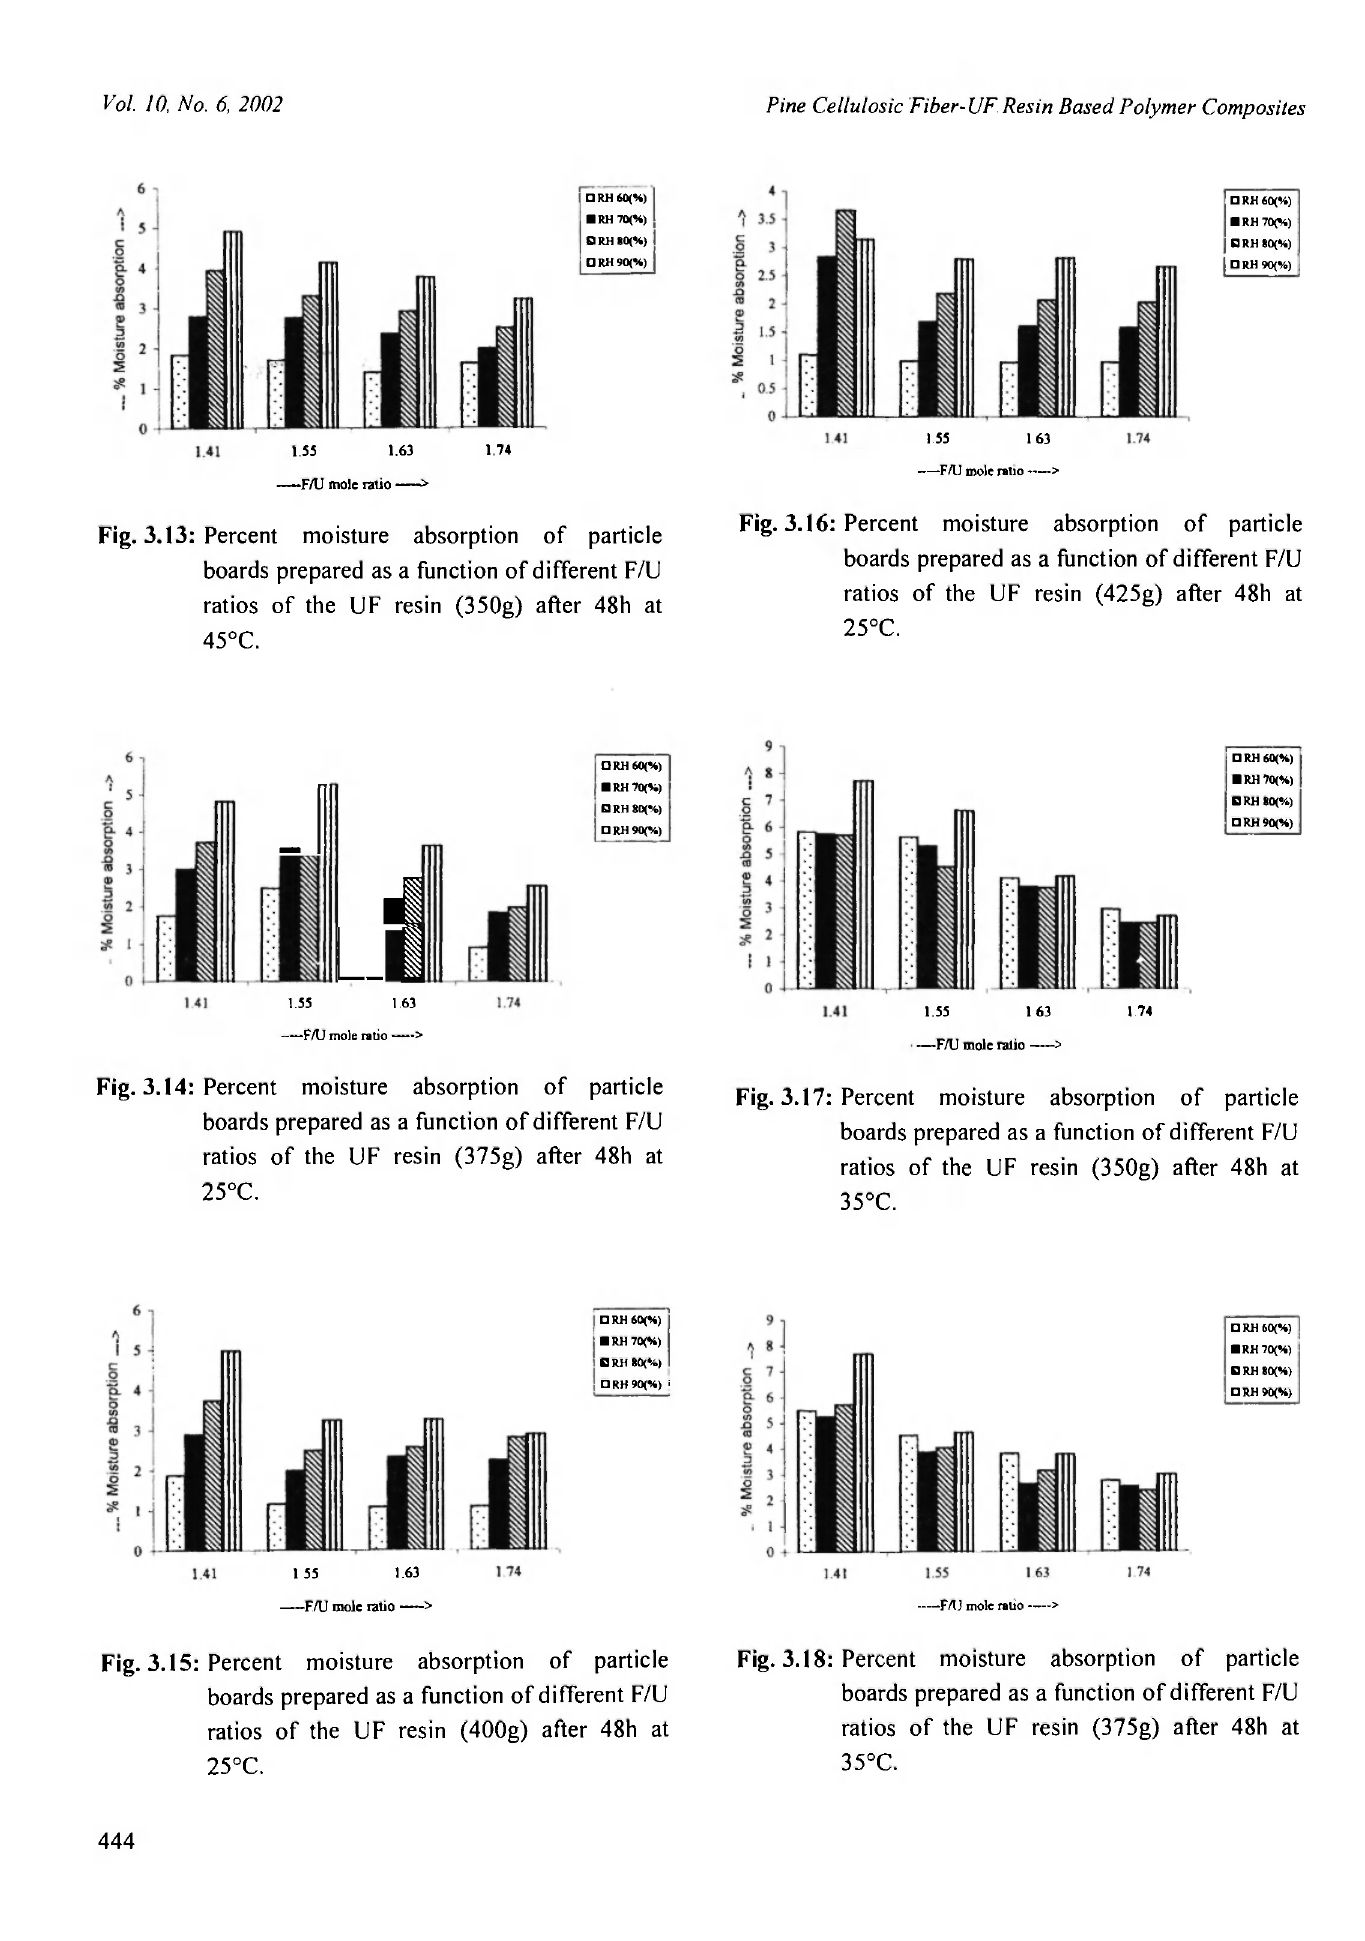
Fig. 3.15: Percent moisture absorption of particle boards prepared as a function of different F/U ratios of the UF resin (400g) after 48h at 25°C.